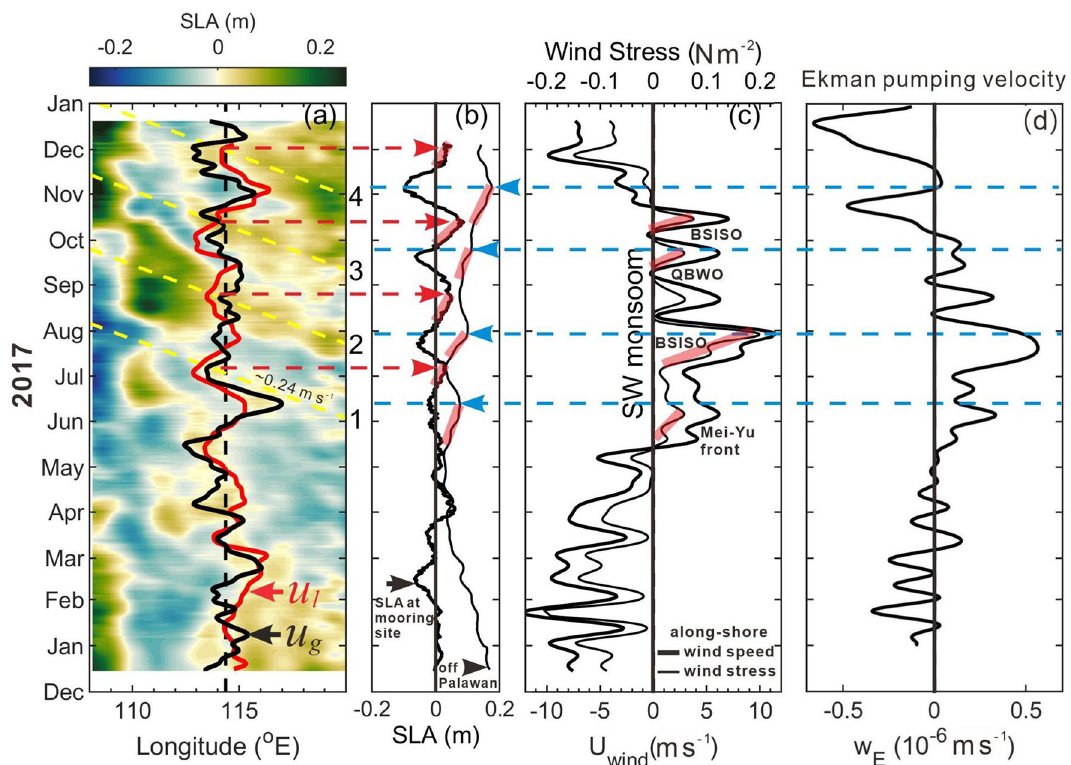
Figure 3. Satellite SLA and wind variation near the ADCP mooring. ( a ) Time versus longitude variation of the satellite SLA at 10.5° N. Black dashed line marks the longitude of the ADCP; red and black curves represent u l and satellite altimeter data derived geostrophic velocity u g (without scale), which are positive (negative) on the right (left) relative to the black dashed line. Yellow dashed lines indicate the westward-propagating SLA signals for four events marked by 1–4 on the right of the panel. ( b ) SLA near the mooring site (thick curve) and the area-averaged SLA (thin curve) in the polygon area enclosed by the red dashed lines off Palawan in Fig. 1a. ( c ) The low-pass-filtered, area-averaged alongshore CCMP wind speed (thick curve) and associated wind stress (thin curve). Red and blue dashed lines indicate timing of positive peak SLA near the mooring site and off the west coast of Palawan, respectively. Transparent red lines indicate rising stages of SLA in ( b ), and strengthening period of wind stress in ( c ) due to the four southwesterly monsoon oscillations marked in ( c ) where QBWO stands for quasi-biweekly oscillations. ( d ) The area-averaged, 8.33-day low-pass-filtered Ekman pumping velocity w E lines in Fig. 3a indicate slopes of the SLA signals, which are determined by connecting the positive peak SLA at the mooring longitude to its possible upstream source of the signal, i.e., off Palawan. The four intraseasonal events are marked by 1–4 on the right of Fig. 3a. The propagation speeds of the four SLA signals, i.e. the slopes of yellow dashed lines, are between 0.2 and 0.3 m s −1 with an average value of 0.24 m s −1 (toward the west), which are within the values derived from satellite altimeter data in the Pacific (0.25–0.35 m s −1 ) 16 and consistent with the theoretical mode-1 baroclinic Rossby wave speed 0.25 m s −1 at 10.5° N 16–18 . Note that the SLA oscillations in Fig. 3a are similar to the composite SLA evolution shown in Fig. 7 of Ref. 11 but the westward-moving Rossby waves speed 0.037 m s −111 is apparently a typo of 0.37 m s −1 . Also note that the phase speed of theoretical baro- tropic Rossby wave with wavelength O (1000 km) (or wavenumber k ~ 10 –6 m −1 ) is approximately 0.4–0.5 m s −1 , which is two times faster than that of mode-1 baroclinic waves. The time-varying SLA near the ADCP mooring and SLA averaged over the polygon area off Palawan (red dashed polygon in Fig. 1a) are shown in Fig. 3b. The zonal and meridional components of CCMP winds (see “Methods” section) were rotated 44° clockwise to be the cross-shore and alongshore directions, respectively. Figure 3c shows the low-pass-filtered, area-averaged alongshore wind speed and corresponding wind stress. The peak SLA at the mooring site is indicated by red dashed arrow in Fig. 3a,b; the peak area-averaged SLA off Palawan is indicated by blue dashed arrow in Fig. 3b–d. Comparing Fig. 3b with a and c, the four peak SLA signals off Palawan lead the peak SLAs at the mooring location by ~ 25–30 days, and the peak SLAs off Palawan are visually correlated with the strengthening of the southwesterly (alongshore wind off Palawan) particularly for event 1, 2, and 3. We also compare the intraseasonal velocity variation with the SLA signals in Fig. 3b and alongshore winds in Fig. 3c during the boreal winter months, and find that the correlations between these vari- ables are not as clear as those during the summer months. Examining the dynamics underlying these wintertime intraseasonal oscillations is beyond the scope of this study but merits a future study.